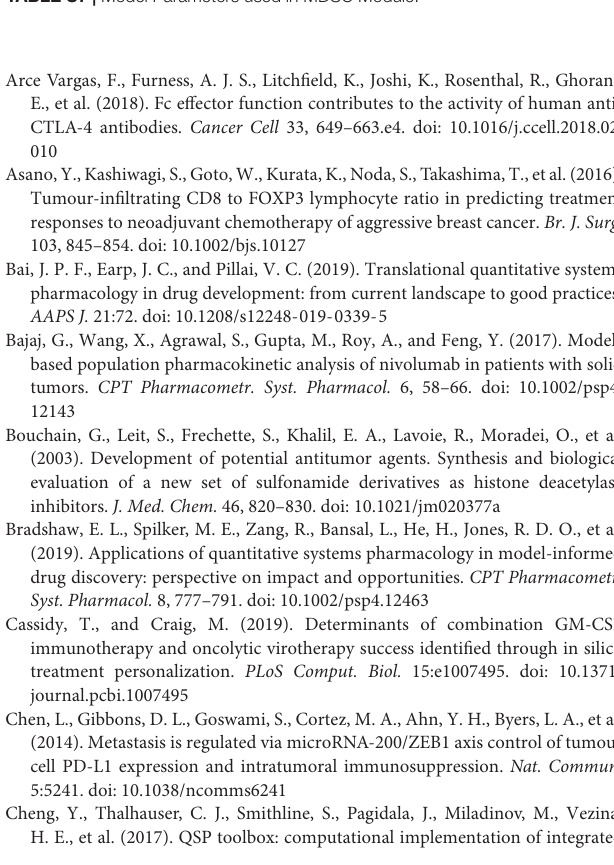
FIGURE S1 | Antiproliferative effect of entinostat (ENT) on Breast Cancer Cell. 1-Hill function of inhibitory effect of ENT vs. its concentration (A) , and number of cancer cells vs. time (B) . Experimental data is from Lee et al. (2001) (PMID: 11221885). WT, wild type. Exp, experiment. Sim, simulation. FIGURE S2 | Arginase I and nitric oxide expression. The error bars represent the range of arginase I (A) and nitric oxide (B) in virtual patient cohort, fitted to experimental data from Serafini et al., 2008 (PMID: 18593947). FIGURE S3 | MCP-1/CCL2 Expression (A) and Recruitment of MDSC (B) . Range of CCL2 expression is fitted to data from Dutta et al. (2018) (PMID: 29594759), and effective concentration of CCL2 on recruitment of MDSC into the tumor is optimized to match the migration index reported by Huang et al., 2007 (PMID: 17257744). TABLE S1 | Model Compartment Name, Capacity, Unit, and Description. TABLE S2 | Model Parameter Name, Value, Unit, and Description. TABLE S3 | Model Reaction, Reaction Rate, and Description. TABLE S4 | Model Algebraic Equations (Model Rules). TABLE S5 | Model Species Name, Initial Amount, Unit, Location, and Description. TABLE S6 | Model Events. TABLE S7 | Model Parameters used in MDSC